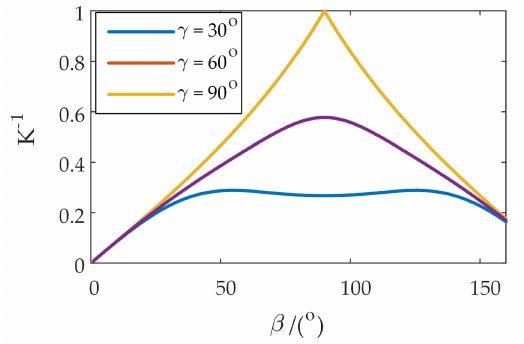
Figure 12. Curve of the reciprocal of the condition number and uplift